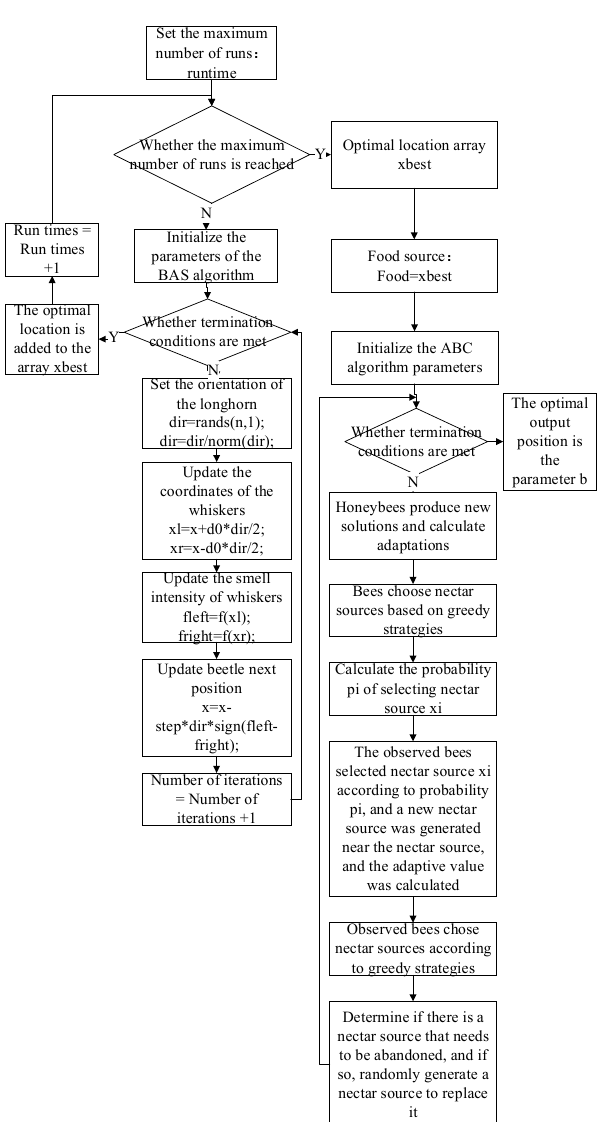
Figure 1. Implementation of the BAS-ABC algorithm.